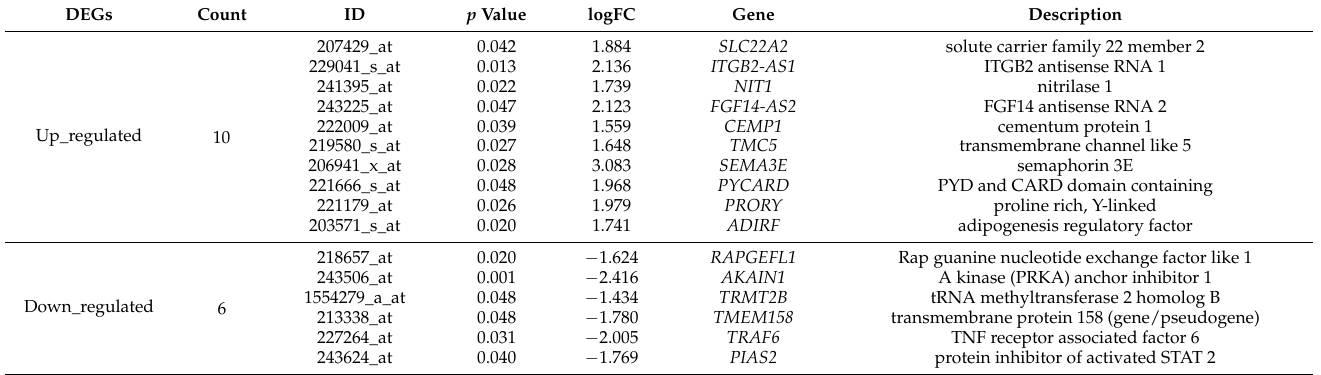
Table 1. 16 DEGs associated with